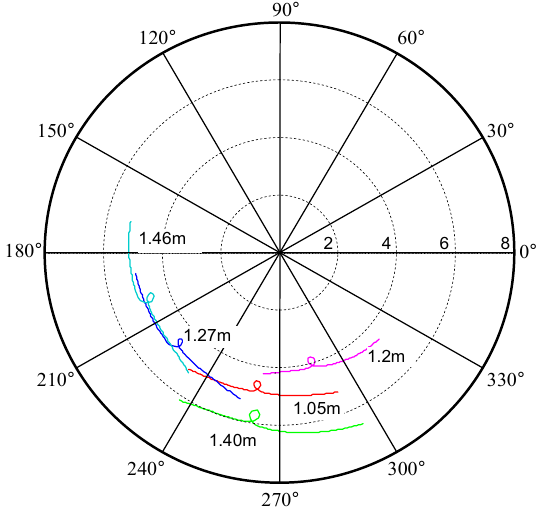
Figure 2. Measured signals in ideal environment.